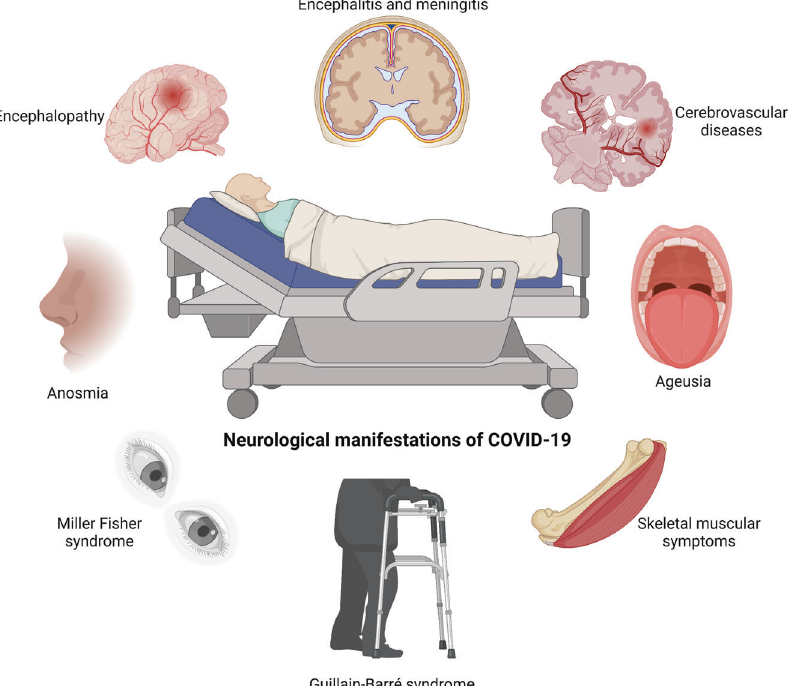
Fig. 1 SARS-CoV-2-associated neurological symptoms. A variety of neurological manifestations are present in COVID-19 patients, such as encephalitis, encephalopathy, ageusia, anosmia, Miller Fisher syndrome, and Guillain-Barré